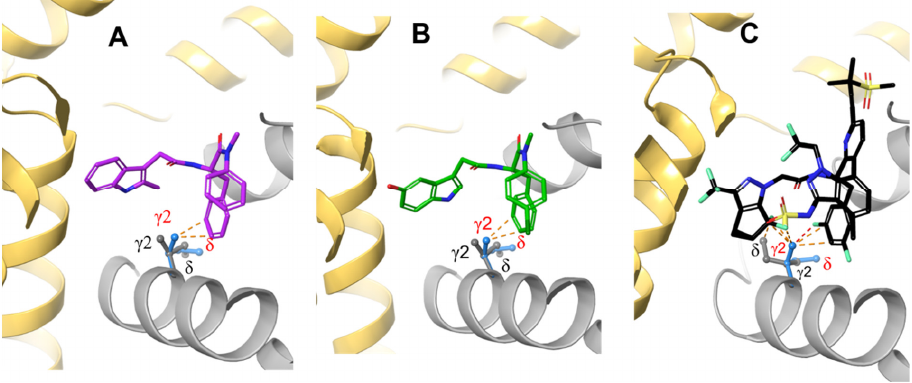
Figure 5. Representative MD snapshots of ( A ) PF74 (purple); ( B ) ZW-1261 (green); and ( C ) GS-6207 (black) in complex with the M66I CA mutant (gray and yellow cartoon, the I66 side chain is depicted by gray sticks). For comparison, the I66 side chain of the apo M66I mutant is depicted by light blue sticks in all panels.